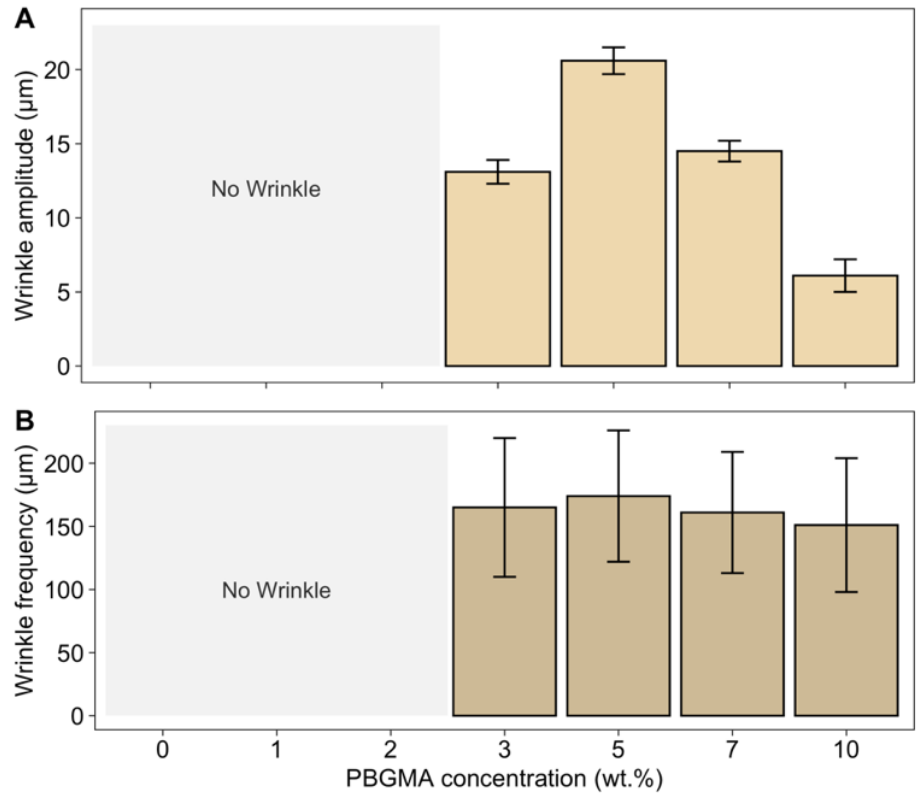
Figure 9. ( A ) Wrinkle amplitudes and ( B ) frequencies according to PBGMA concentration. Three samples per formulation were analyzed. The amplitude values are averaged from three measurements and the frequency values from an average of 100 random X profiles.